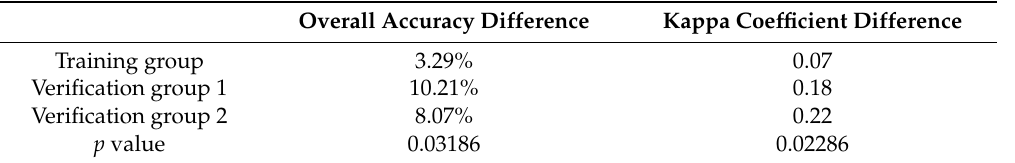
Table 13. t -Test for